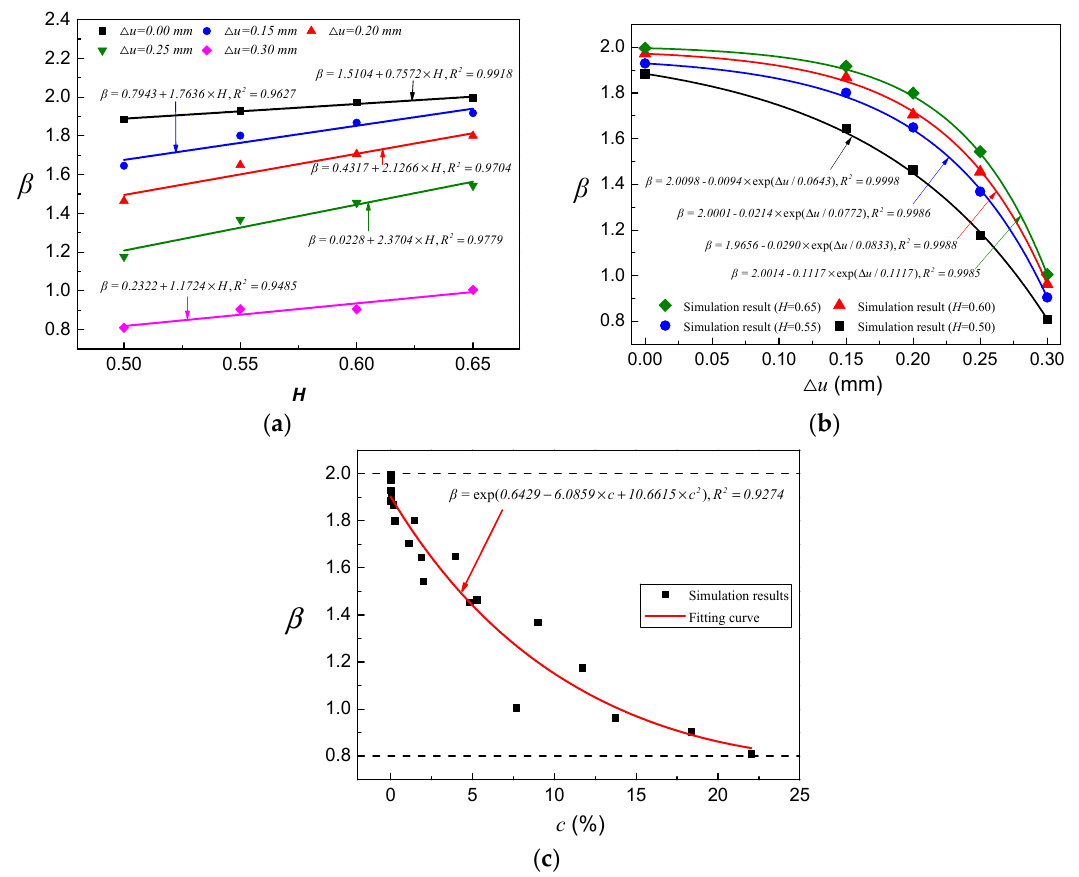
simulations and the fitted results: ( a ) ADE fitting; ( b ) CTRW fitting.